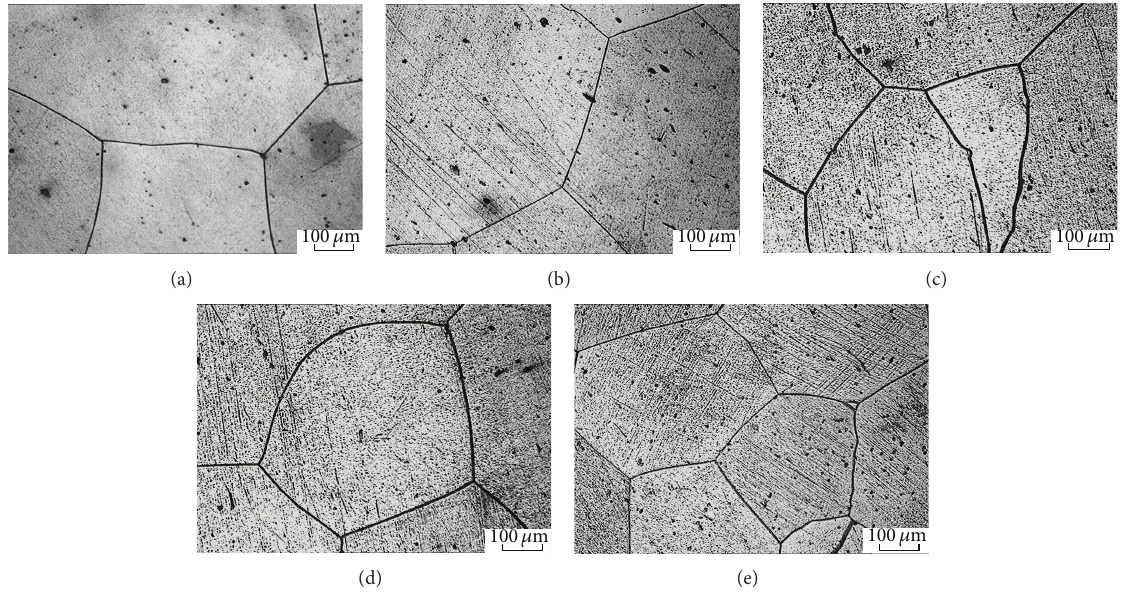
Figure 6: Micrographs of tested FSS 429 aging at 550 ∘ C for different time: (a) 15min, (b) 30 min, (c) 1h, (d) 2 h, and (e) 8h.